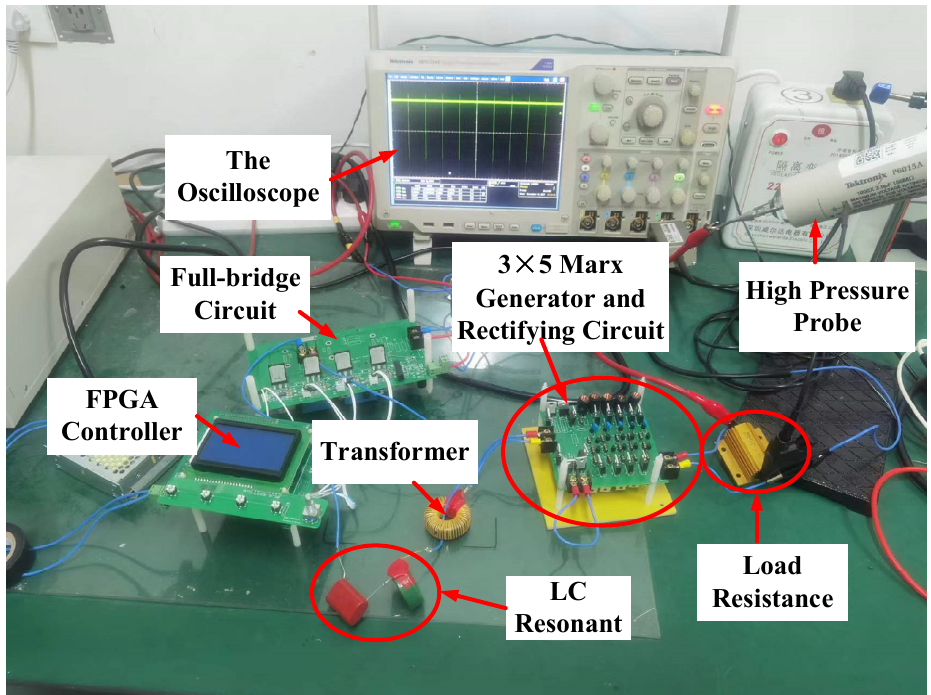
Figure 7. A photograph of the 3 × 5 stage Marx generator based on the avalanche BJTs.